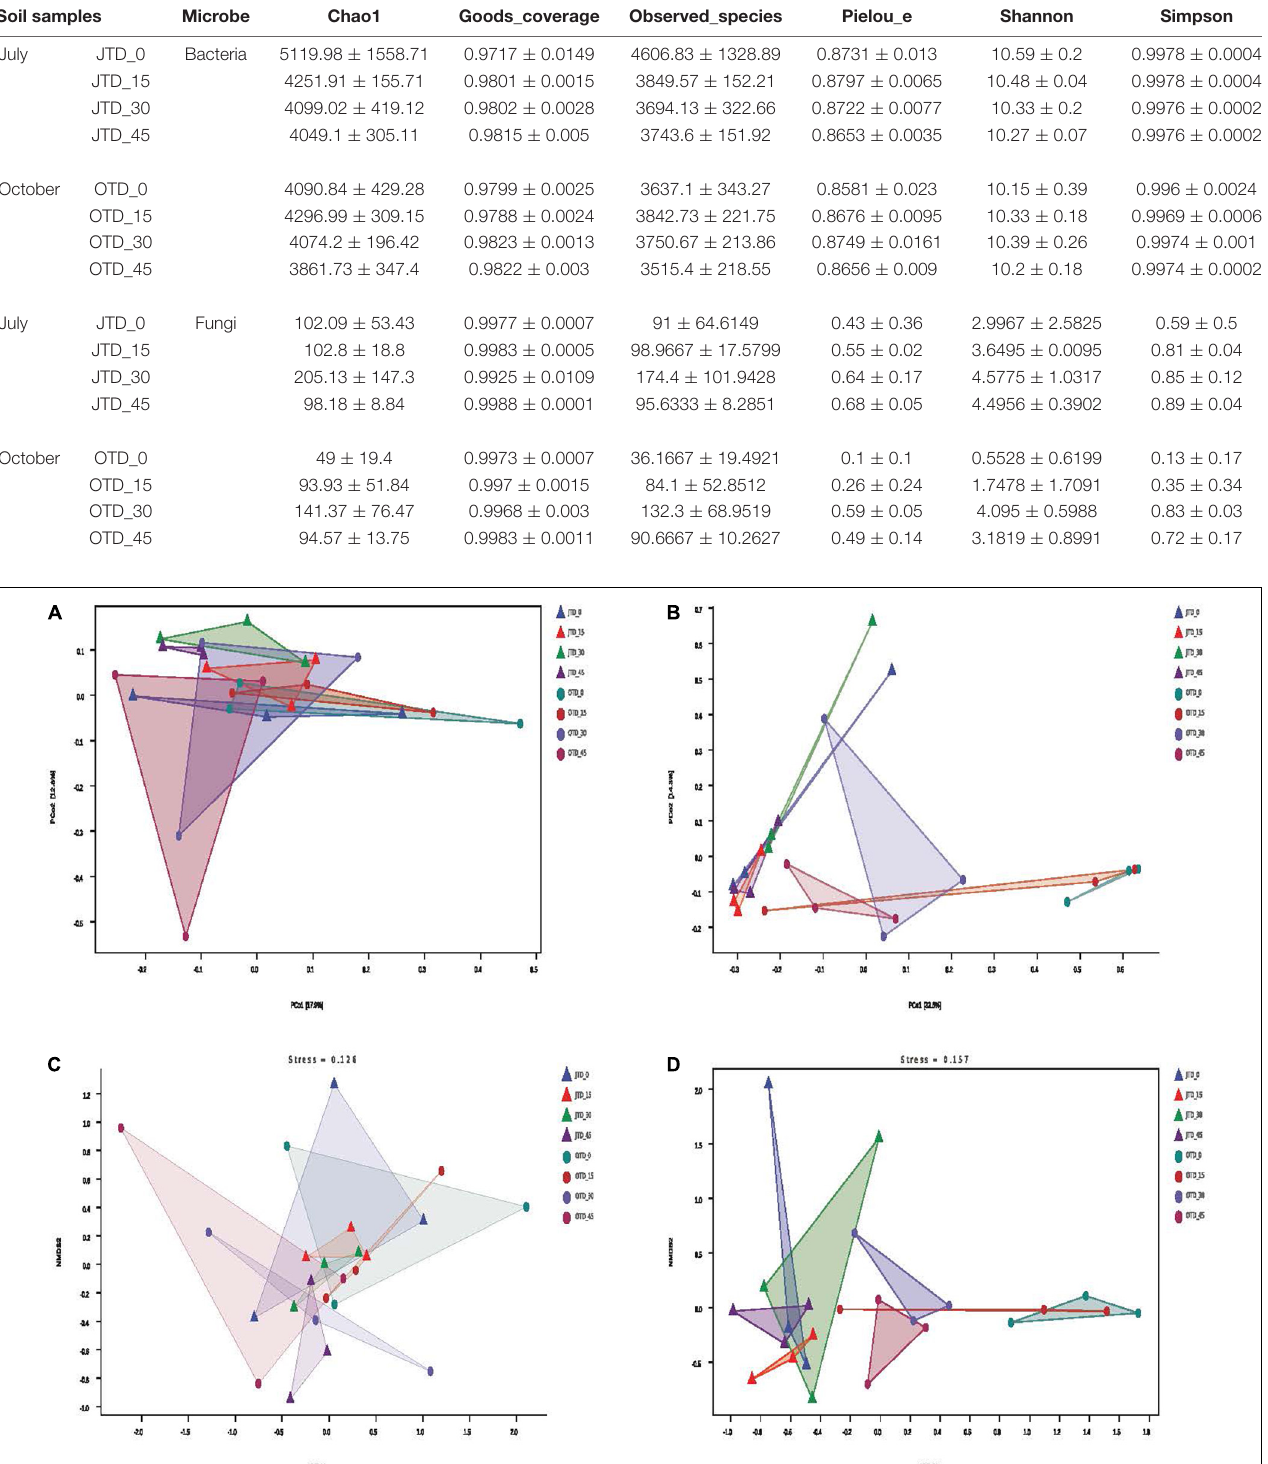
TABLE 2 | Soil bacterial and fungal within habitat diversity index based on the Illumina Miseq sequencing data from July and October under different crude protein diets.